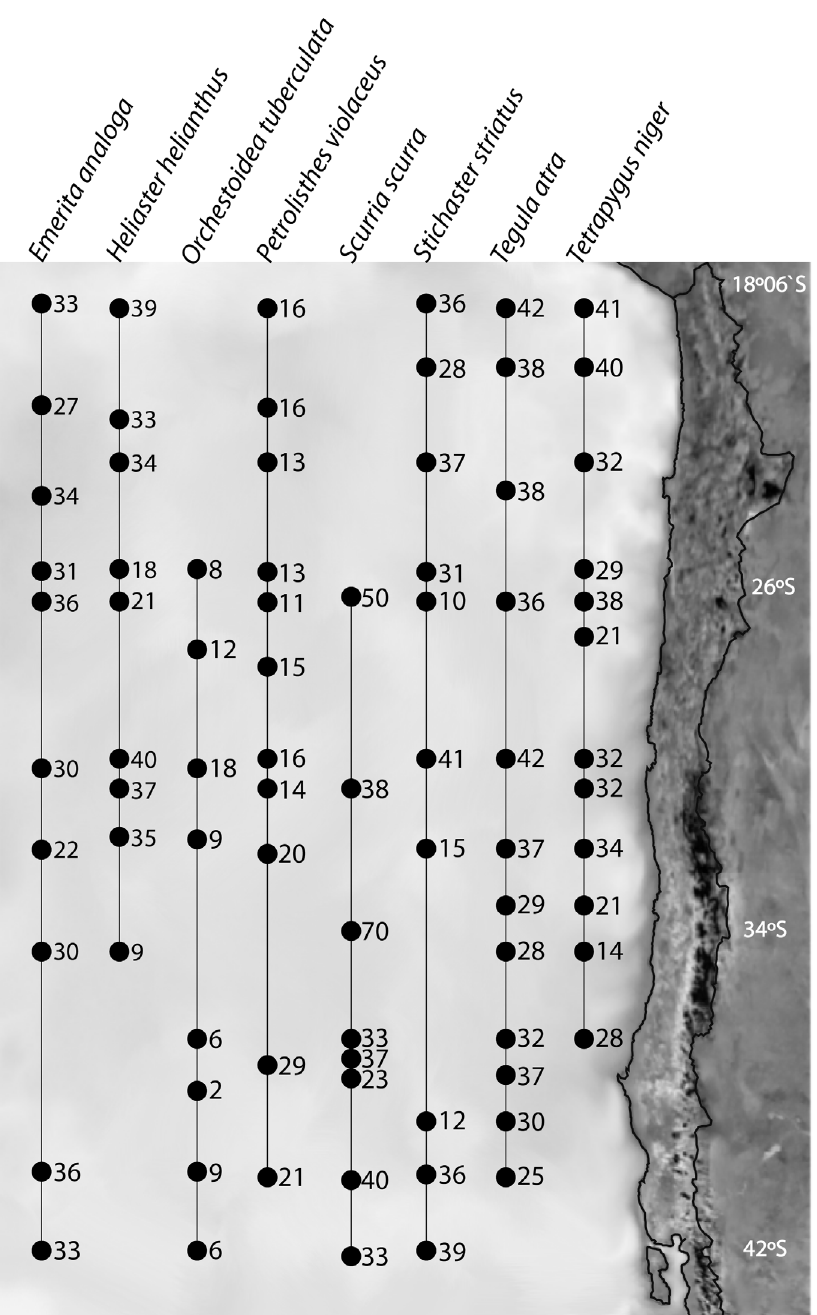
Figure 1. Map of the study area along the coast of Chile indicating the sampling sites and the sample size per site for each of the analyzed species.